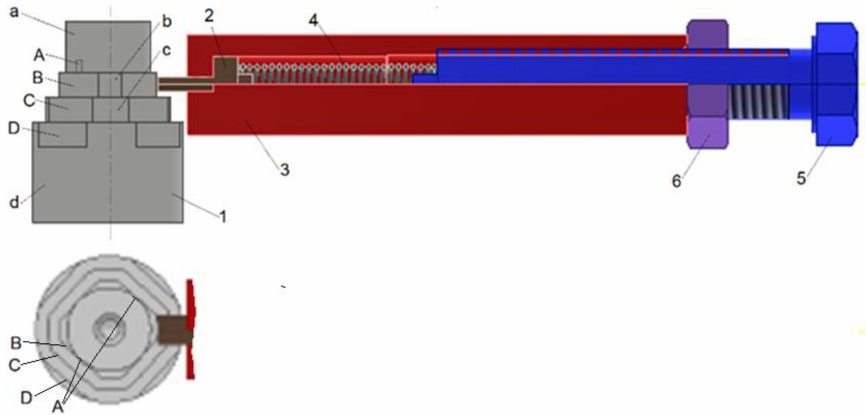
Figure 7. The model of wear in contact zones between an eccentric and a swivel arm. 1—shaft, 2—punger, 3—support, 4, spring, 5—set screw, 6—lock